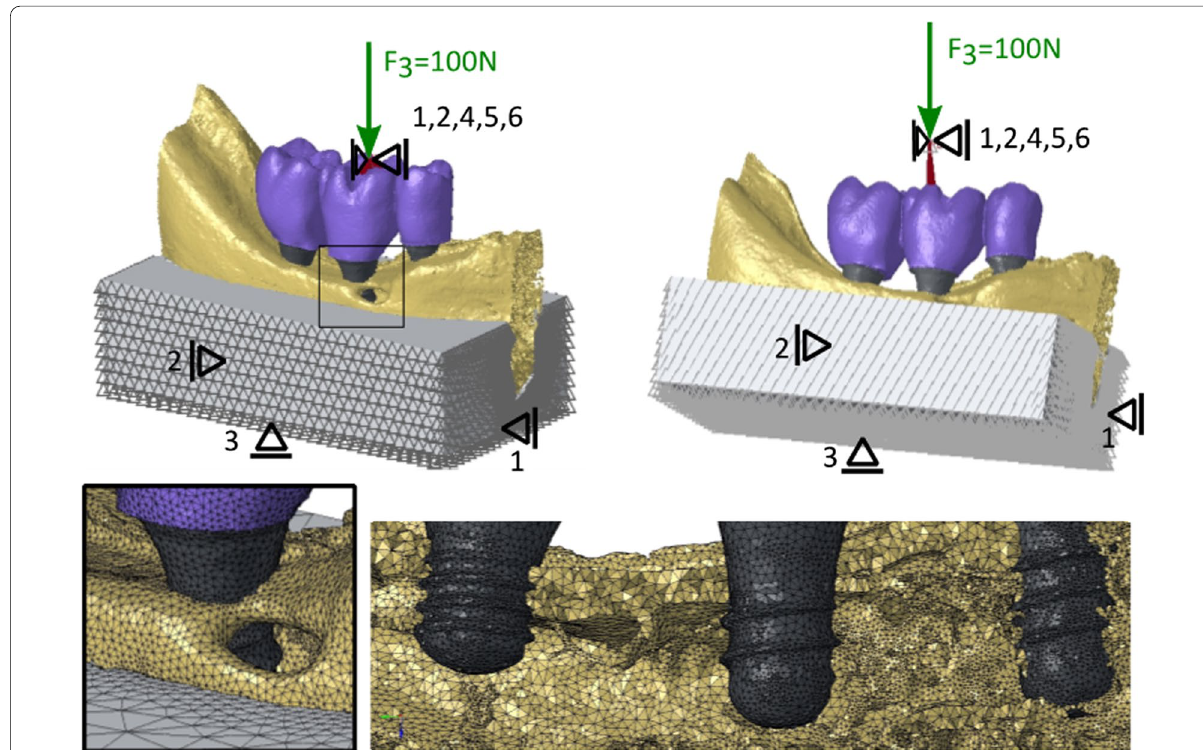
Fig. 2 Components, boundary conditions, and mesh density of a study model. An example of the splinted, 3-implant configuration is shown for the loading of the 1st molar. Components of the assembly: prosthetic restoration (violet), implants (dark grey), bone (yellow) and embedding (light grey). The model is aligned vertically (top left) or tilted at 30° (top right). The vertical force of 100 N (green arrow) with DOF 3 is applied on the reference node. The node is constrained in all directions (black support symbols including numbers), except the vertical direction (DOF 3). Kinematic coupling (dark red) is done with all DOFs. The embedding is constrained as indicated. The inset on the left bottom shows the mesh at the boundaries between crown, implant, bone and embedding. The bottom right image illustrates the osseointegration of the implants in the